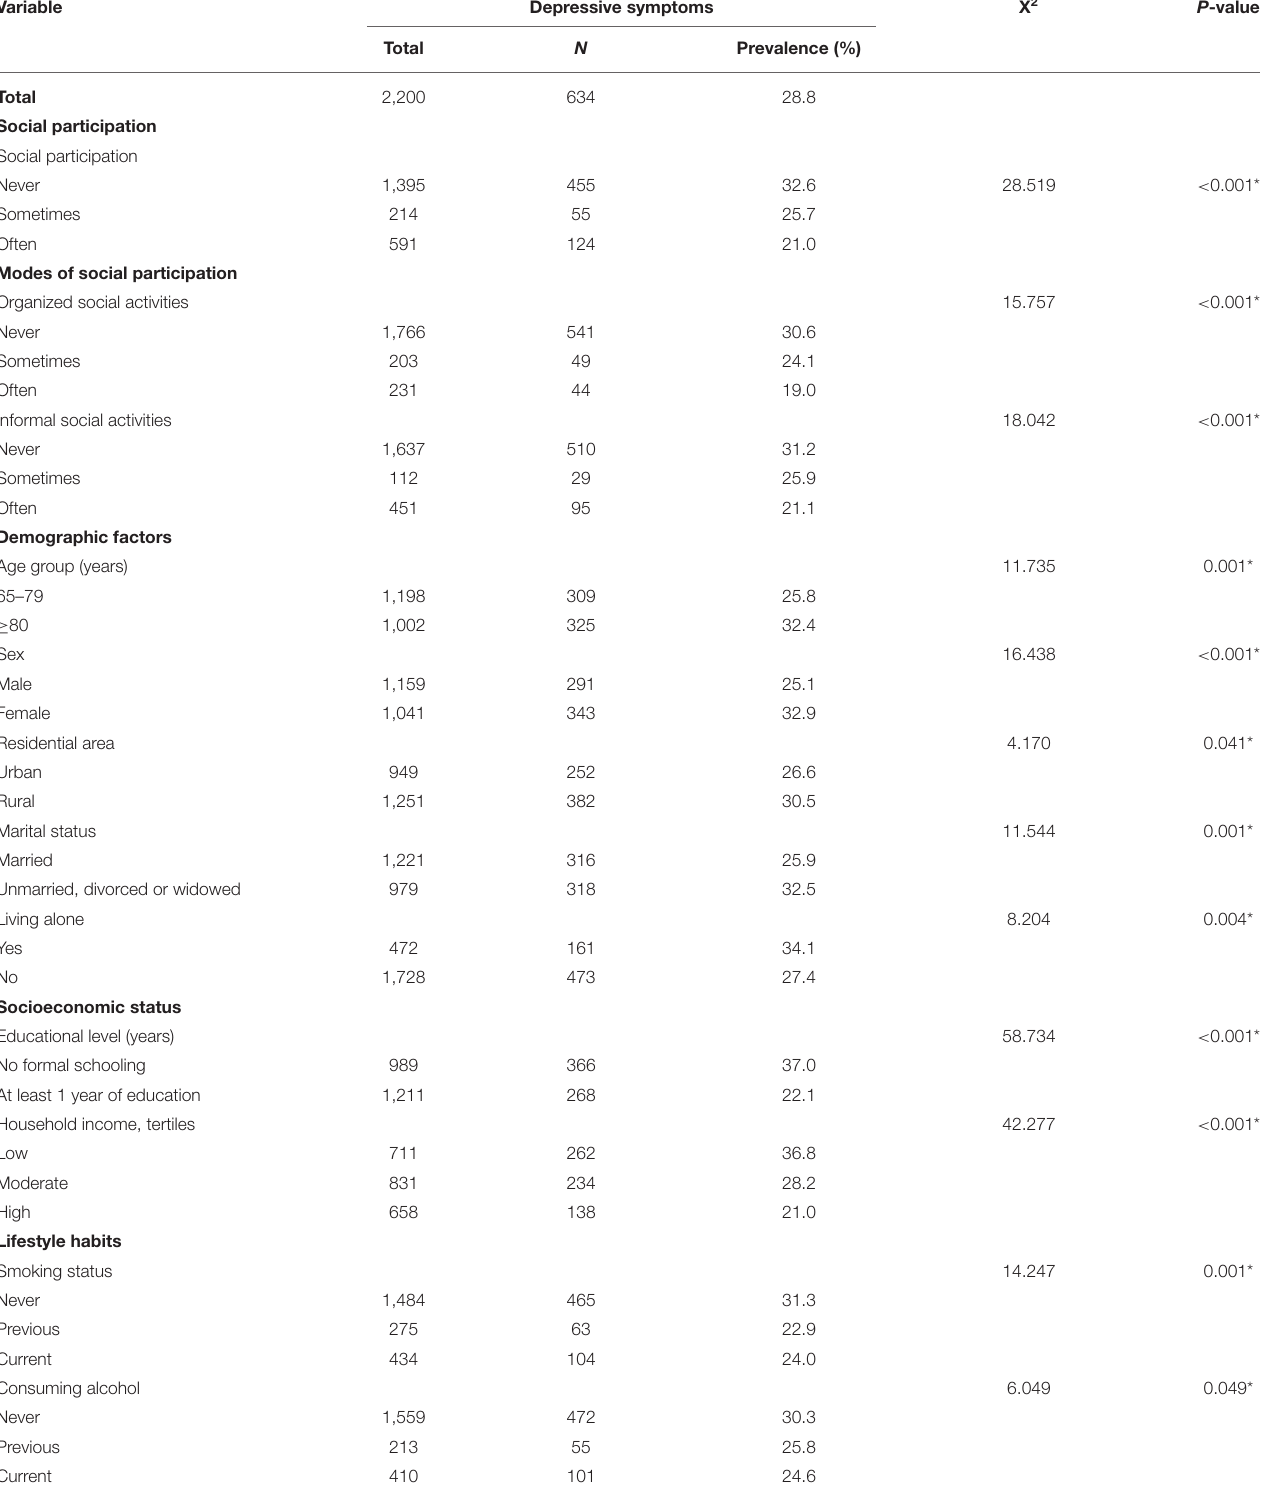
TABLE 2 | The incidence of depressive symptoms among Chinese older adults by social participation status, demographic factors, socioeconomic status, lifestyle habits, and health status.